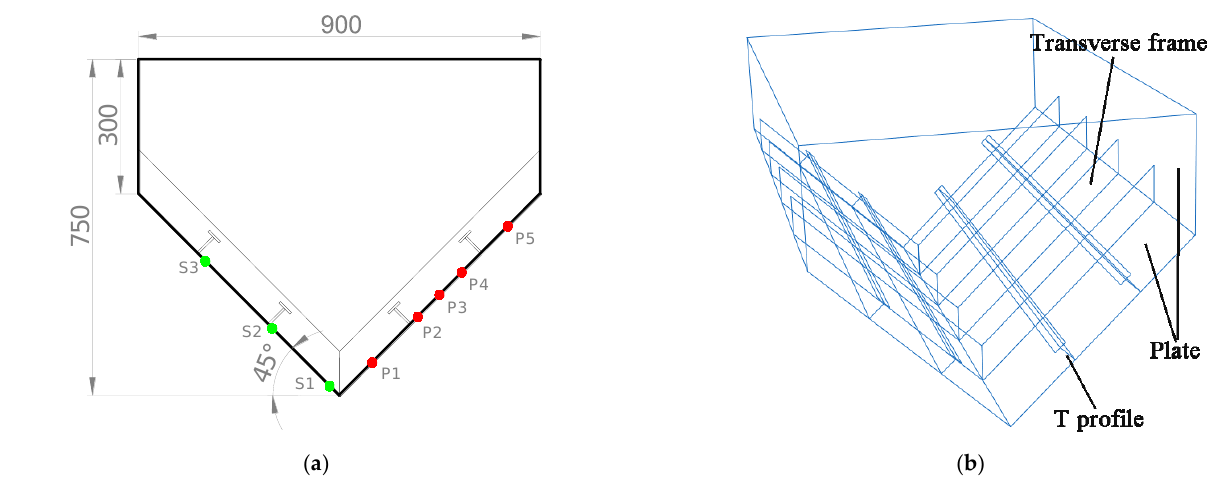
Figure 1. Sketch of the wedge structure model. ( a ) transverse plane (unit in mm); ( b ) 3D perspective view. Table 1. Main parameters of the wedge structure and the stiffeners.